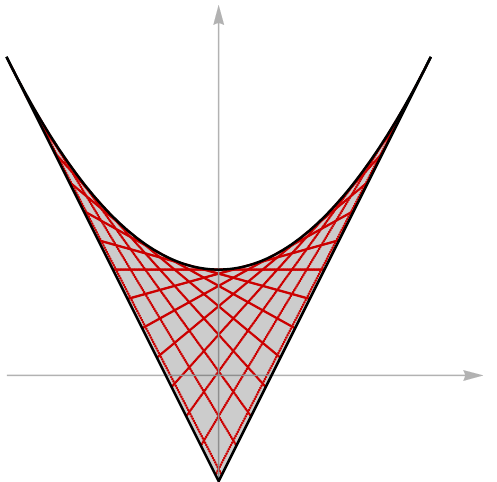
Figure 20 . The images of the points of ~ S 0 , that correspond to integral ( (cid:11); (cid:12) )-points, in ~ S , plotted for p = 13. At this scale, the points run together to form